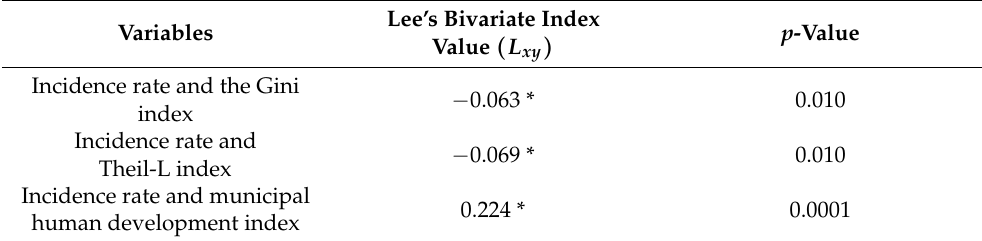
Table 2. Lee’s bivariate global spatial correlation ( L xy ) the incidence rate of COVID-19 cases and the Gini index; incidence rate and Theil-L index and incidence rate and municipal human development index (MHDI) in the period from June to December 2020 in the municipalities of